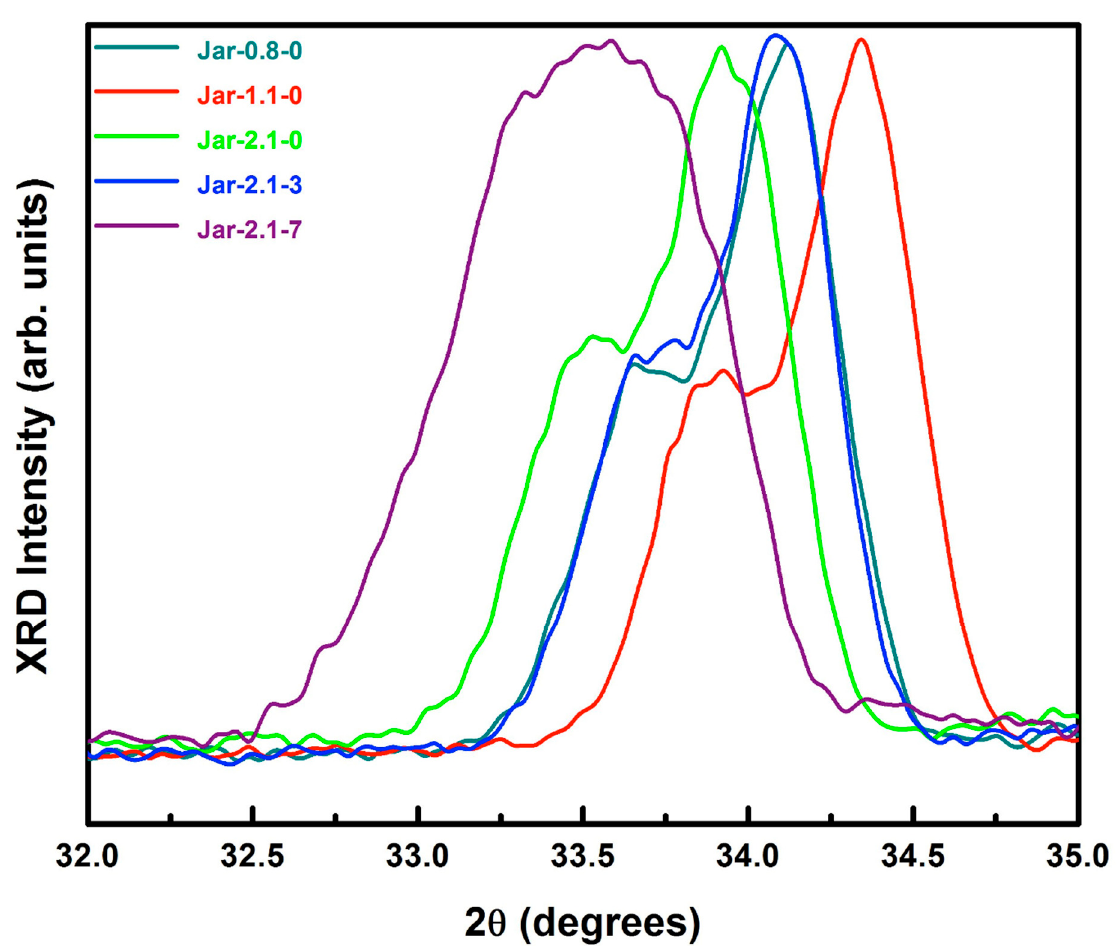
Figure 5. XRD (113) peak shift for all potassium jarosite